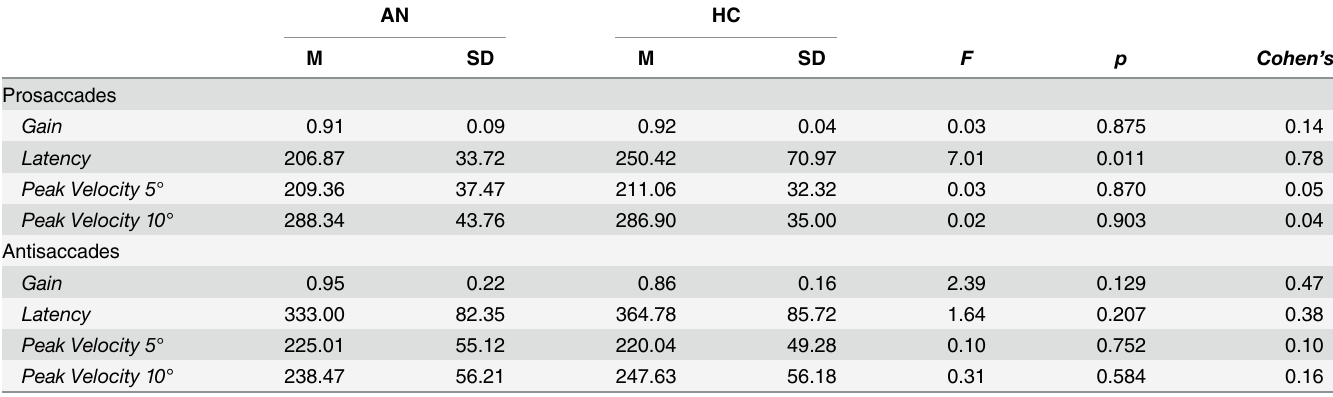
Table 5. Saccade characteristics of correct prosaccade and antisaccade responses.